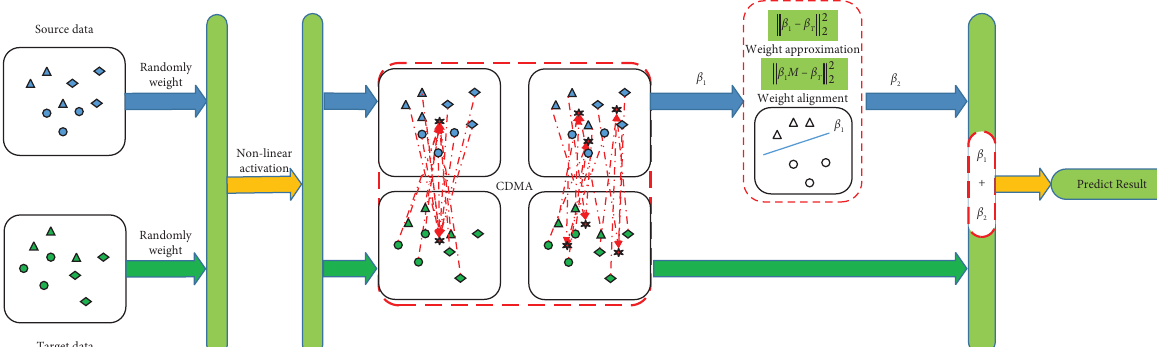
Figure 1: An illustration of JTELM. (1) CDMA is combined with ELM to minimize the distribution discrepancy of output data of hidden layer from two domains. (2) Output weight alignment and approximation could enhance the ability of knowledge transfer of JTELM. (3) Joint decisions of two ELMs improve the robustness of